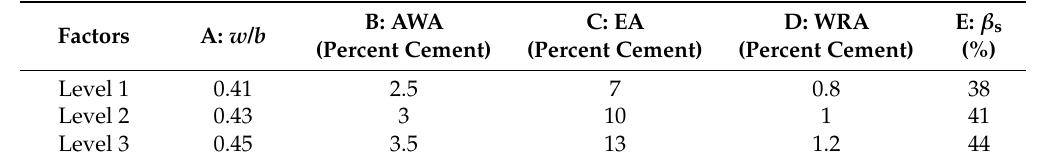
Table 12. The values of different levels of the factors in orthogonal